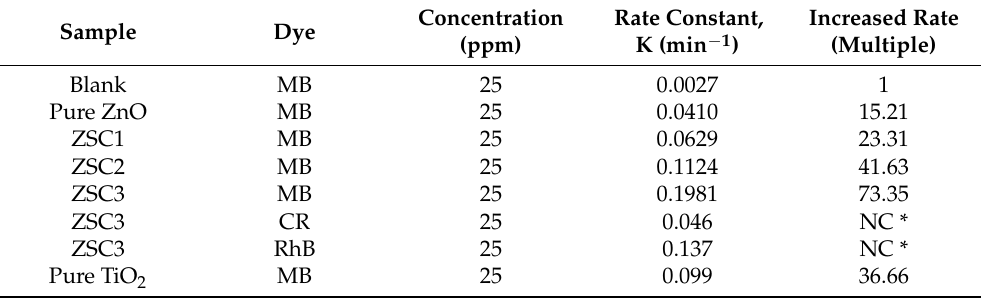
Table 1. The rate constant ( k , min − 1 ) for photodegradation of dyes (MB, CR, RhB).